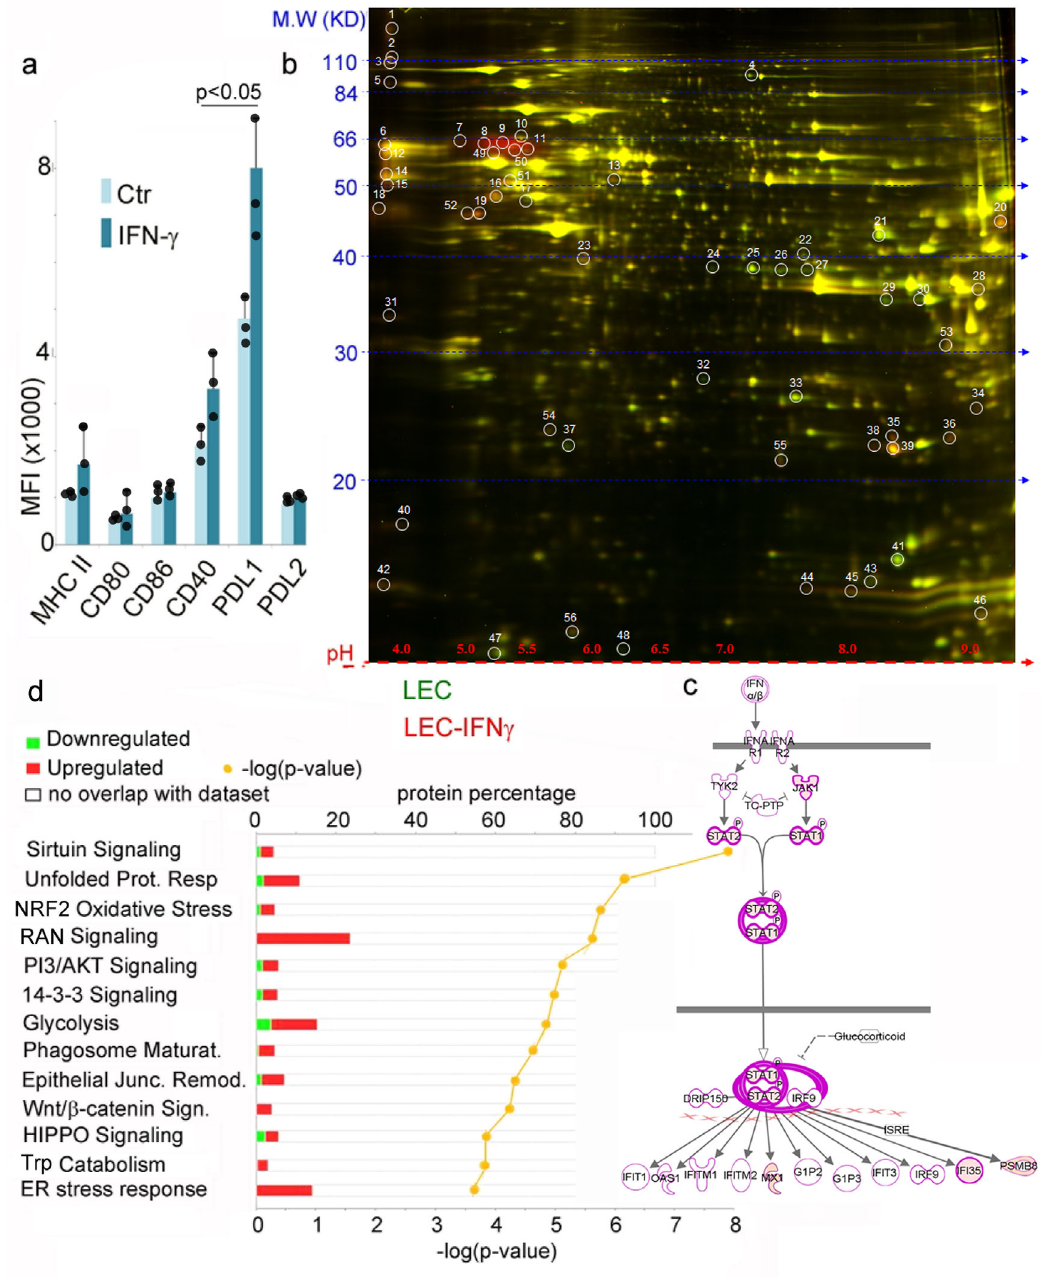
Fig. 3 IFN- γ -stimulated LEC upregulate enzymes of tryptophan catabolism. a Bar graph reporting the mean fl uorescence index and standard deviation of n = 3 biologically independent replicates of FACS analysis for MHC class II and co-stimulatory molecules present at the cell surface of LEC untreated or treated with IFN- γ (100 ng/ml for 24 h). Averages were statistically analyzed using a two-tailed paired student ’ s t test. b 2DIGE of cell lysates (25 μ g of protein) treated as in ( a ): lysates from untreated cells were labeled with Cy3 (green) and lysates from IFN γ cells were labeled with Cy5 (red). Proteins were resolved on a 4 – 20% SDS-PAGE gels and gel images were acquired on a Typhoon 9400 scanner and analyzed using DeCyder Software (V6.0, GE Healthcare). Spots with a LEC/LEC IFN- γ ratio 2.5< or >2.5 were collected for MS/MS analysis (Supplementary Data 1) ( n = 1). c , d The 2DIGE analysis (in b ) was complemented with label-free quantitation (LFQ) proteomic analysis of n = 3 biologically independent replicates (triplicates of untreated or IFN γ - treated LEC as in ( b ). Data are available at ProteomeXchange Consortium via the PRIDE partner repository with the dataset identi fi er PXD015865. Pathway analysis of LEC proteins up- or downregulated following IFN- γ treatment. Data were analyzed with IPA (QIAGEN Inc., https://www.qiagenbioinformatics. com/products/ingenuity-pathway-analysis). For network generation, datasets containing gene identi fi ers (gene symbols) were uploaded into the IPA application together with their rescaled log2 transformation of protein ’ s area ratios, extracted from label-free quantitative (LFQ) MS1 analysis provided by the PEAKS Q module implemented in PEAKS 8.0/8.5. The probability of having a relationship between each IPA indexed biological function and the experimentally determined genes was calculated by the right-tailed built-in Fisher ’ s exact test. The level of signi fi cance was set to a p -value of <0.05. c , d IPA-predicted upregulation (in red) of in fl ammatory pathways in IFN γ -treated LEC, including ( c ) STAT1-mediated intracellular signaling.